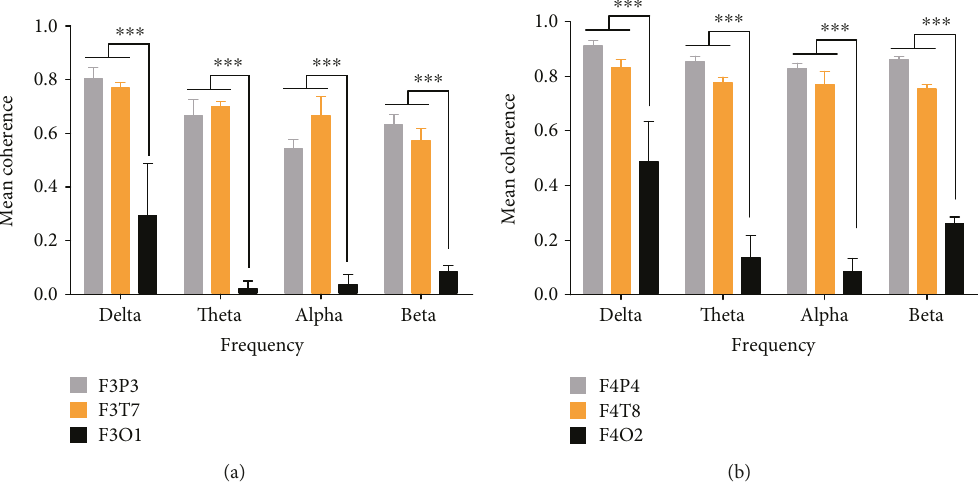
Figure 2: Mean coherence values for deception. Error bars depict standard error mean. (a) The mean coherence for the F3P3, F3T7, and F3O1 electrode pairs in the left hemisphere. (b) The mean coherence for the F4P4, F4T8, and F4O2 electrode pairs in the right hemisphere. ∗∗∗ p < 0 001